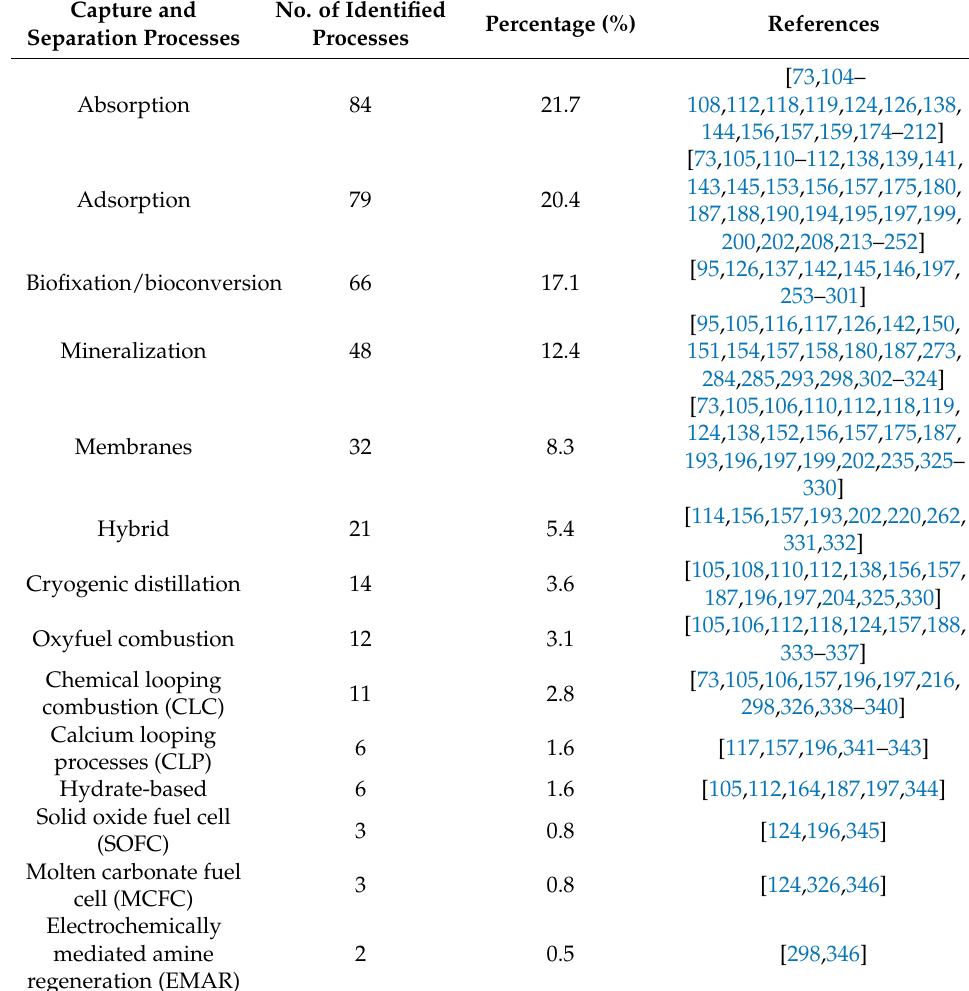
Table 12. Citing frequency of CO 2 capture and separation techniques.